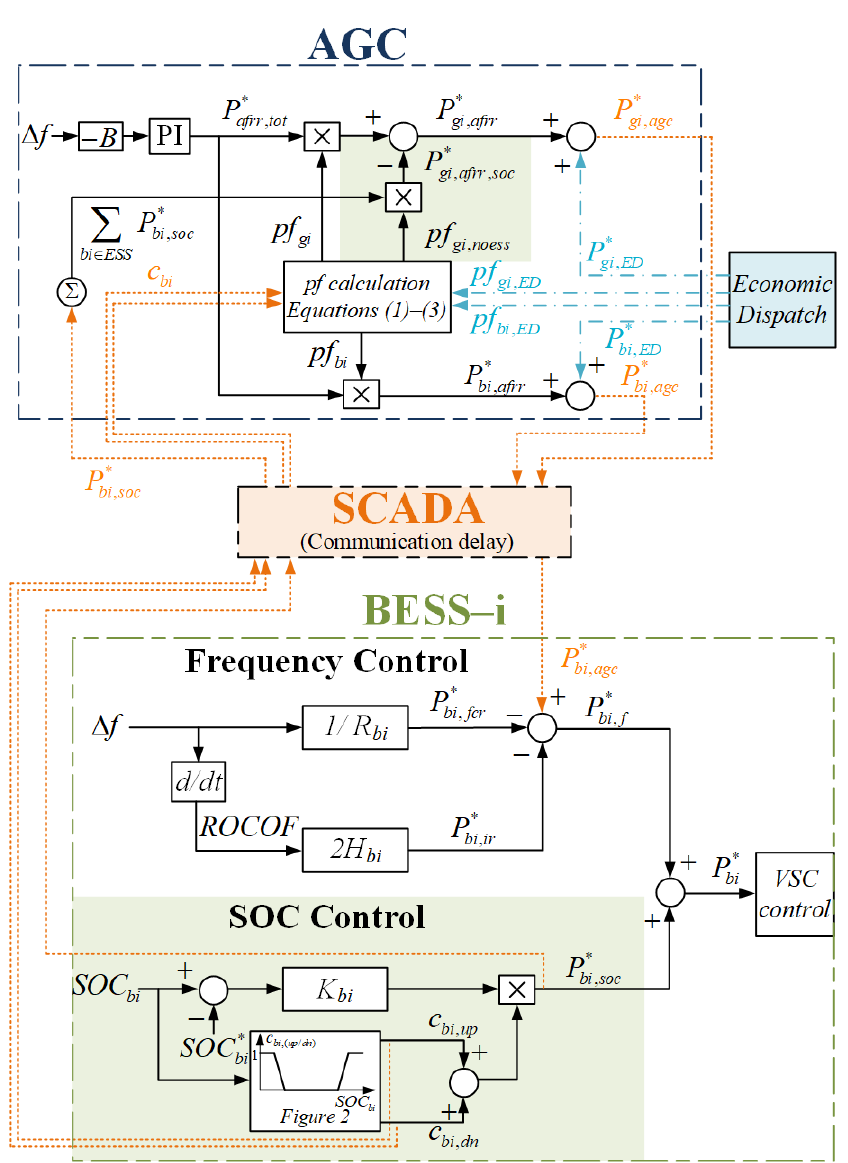
Figure 1. Proposed active power and frequency control scheme implemented locally (battery energy storage system-BESS) and centrally (automatic generation control-AGC).